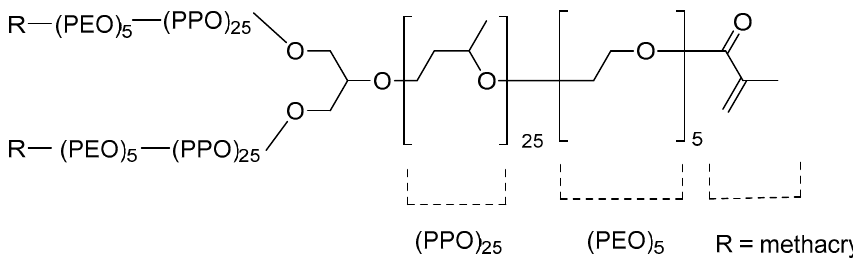
Figure 1. Chemical structure of the methacrylic derivative of Bayfit® 10WF15 (Bayfit-MA).